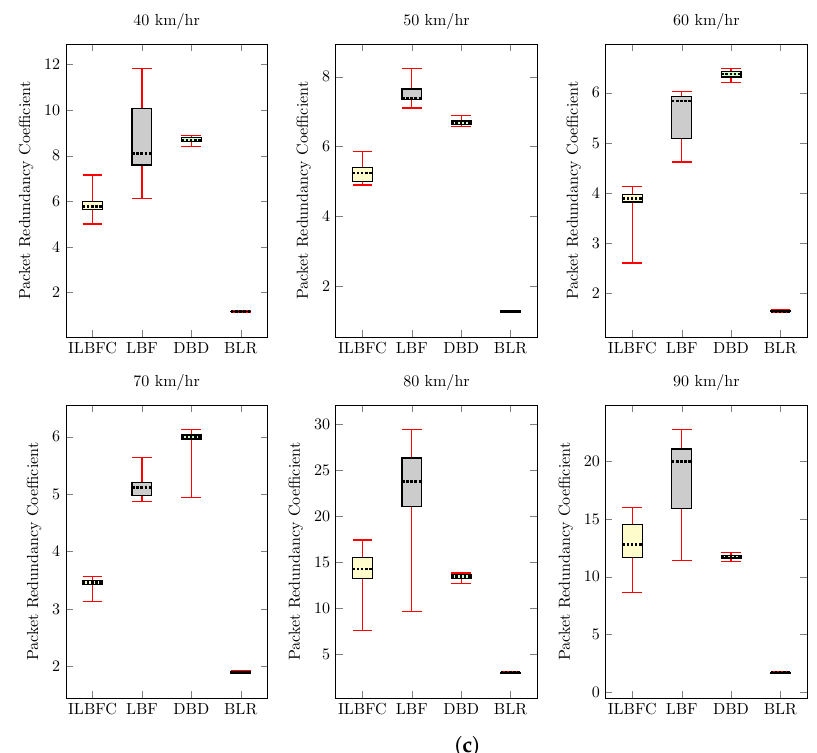
Figure 7. Performance comparison of ILBFC with LBF, DBD and BLR versus maximum node velocity while keeping the source transmission rate equals 400 kbps and the number of nodes equals 40